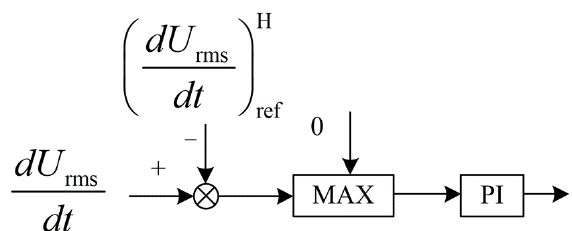
Fig. 8. Diagram of transient high voltage suppression